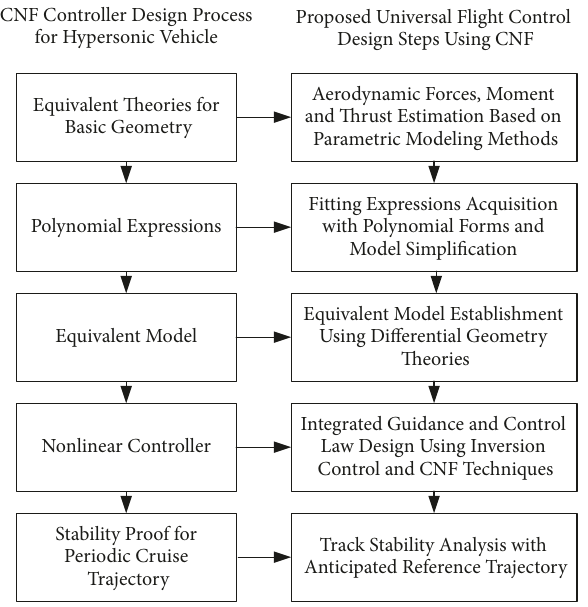
Figure 3: General design steps for flight control law Using CNF